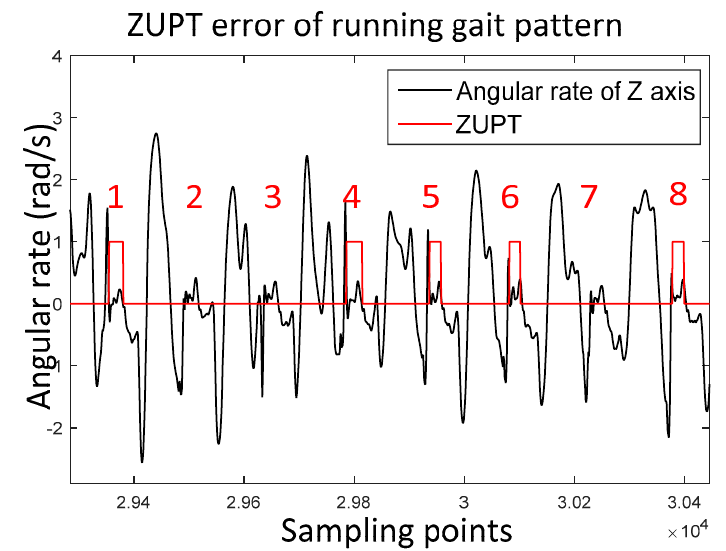
Figure 5. Stance phase detection errors of running gait pattern. The black wave contains eight running gait cycles. The red line represents ZUPT results in which 1 is the stance phase and 0 is the swing phase. The numbers from 1 to 8 are the identifier of the gait cycle.